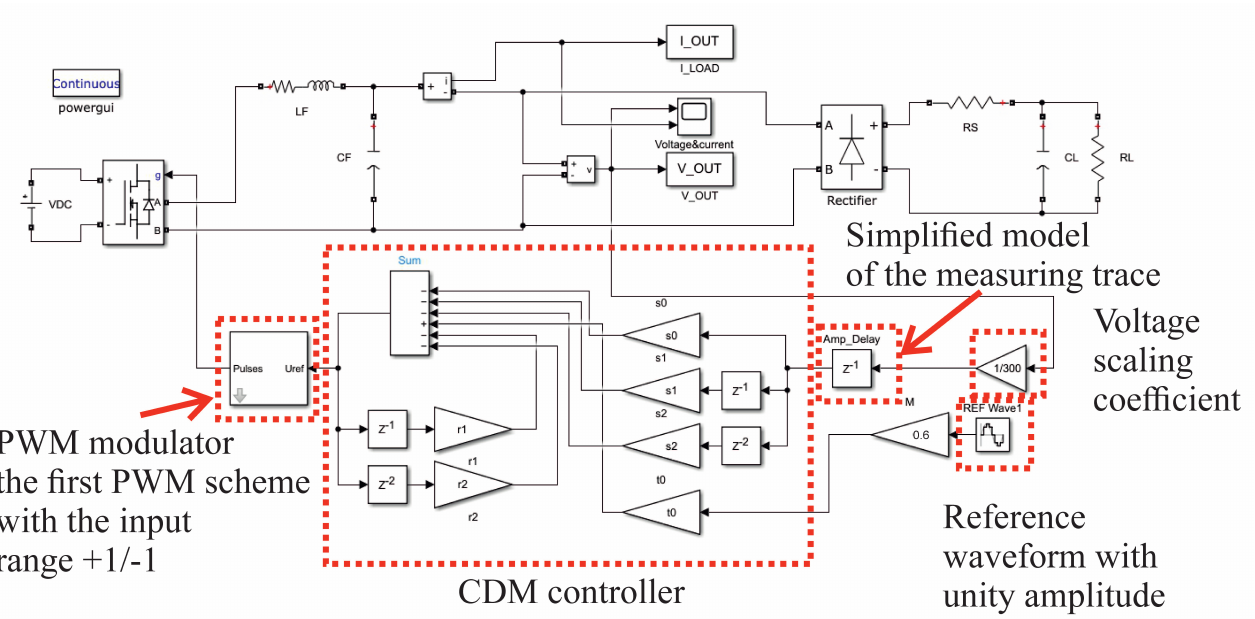
Figure 4. The MATLAB’s Simulink model of the VSI with SISO-CDM